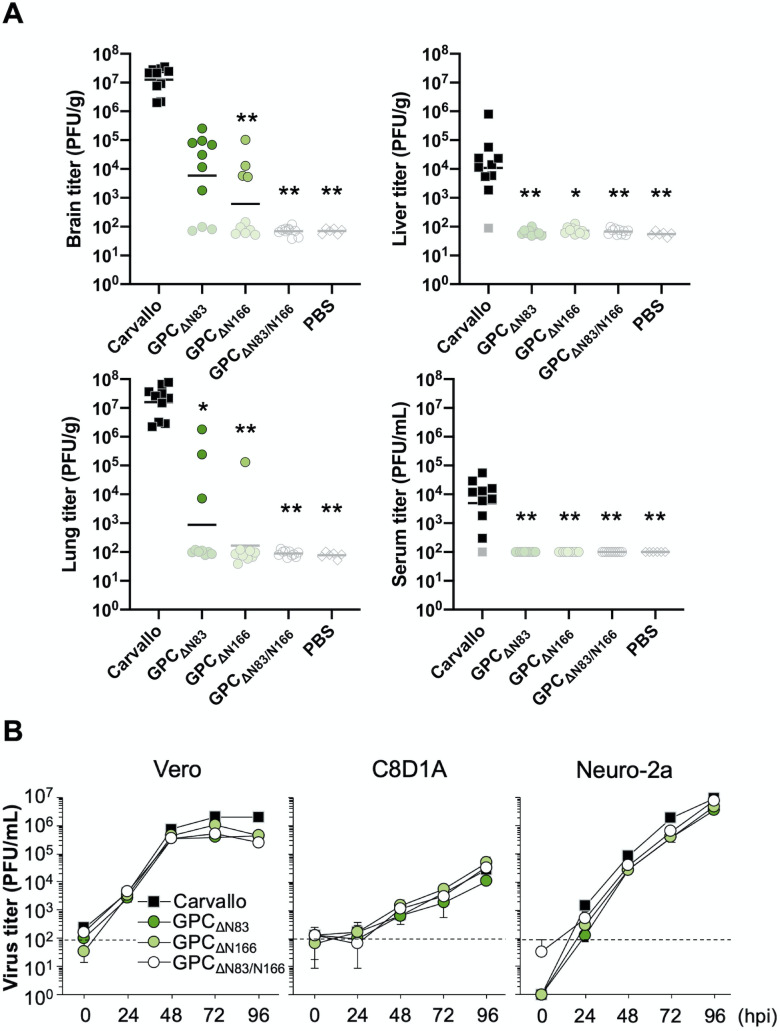
Effects of the N-glycans on virus dissemination and growth curves.(A) Virus titers in brain, lung, liver and serum. Samples under the detection limit were plotted with their detection limits in whitish color. The solid bar represents the geometric mean of the titers. The data of Carvallo- and PBS-inoculated mice in Fig 5A were overlapped with the data in Fig 2A since these infectious experiments were performed together at the same time. Statistically significant differences compared with Carvallo are indicated by asterisks (*, P<0.05 and **, P<0.01 by Dunn’s post-test after Kruskal-Wallis test). (B) Virus growth of MACV GPCΔN83, MACV GPCΔN166 and MACV GPCΔN83/N166 was characterized in Vero, C8D1A and Neuro-2a cells (MOI = 0.01). The dashed line indicates the detection limit. Data shown are averages of triplicate wells with error bars indicating the SD. The data of Carvallo in Fig 5B was overlapped with the data in Fig 2B since these infectious experiments were performed together at the same time.